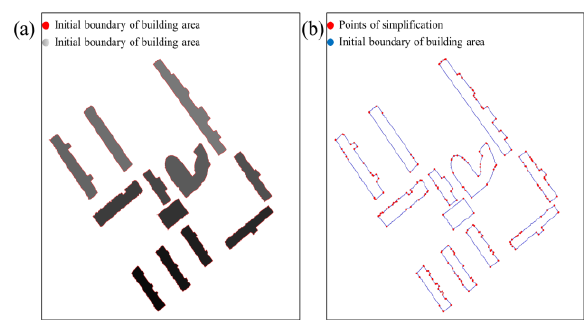
Figure 7. Building area(a) and simplification